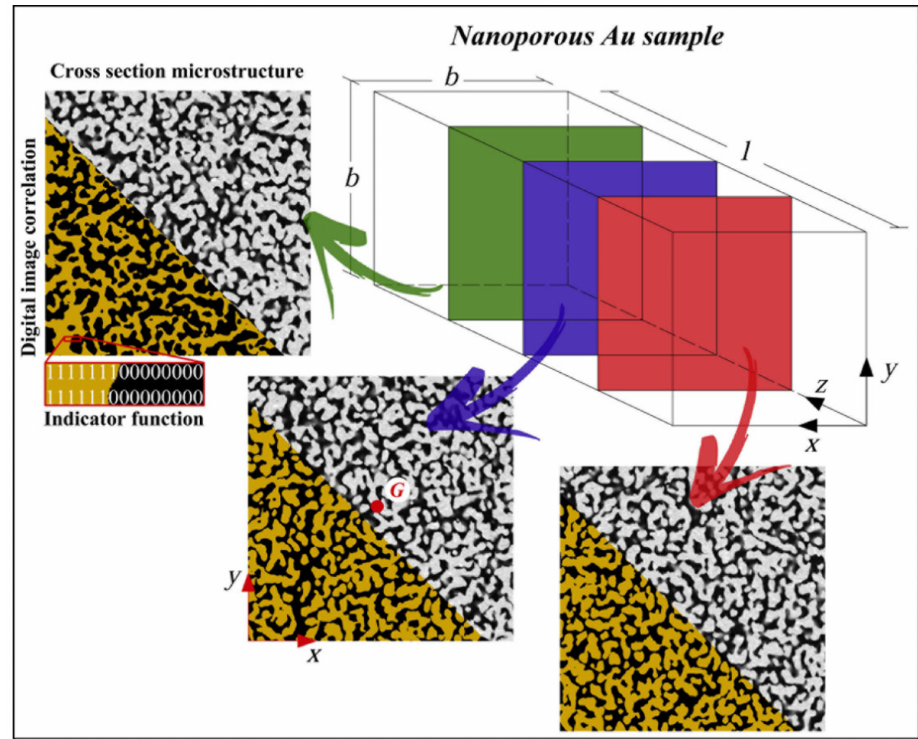
Figure 1. The NP Au sample with sides b = 7.2 µ m and l = 12.8 µ m. The 256 sections obtained by SBF-SEM have been transformed by digital image correlation in a voxel structure. Gold and black colors indicate solid and void phases. The indicator function θ void